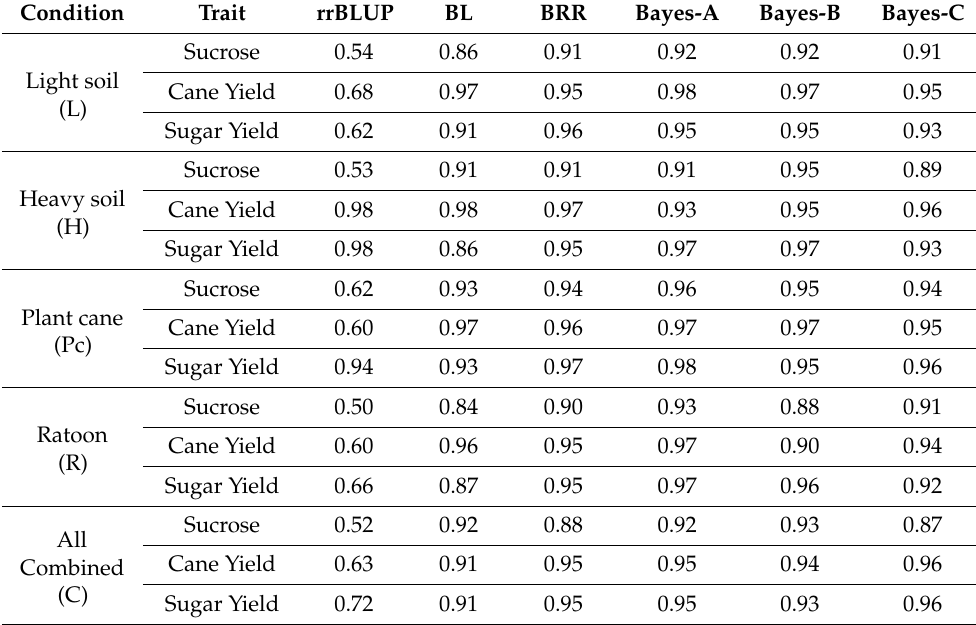
Table 3. The rank correlation between the phenotypic (BLUEs) and predicted values (GEBVs) using various models in different